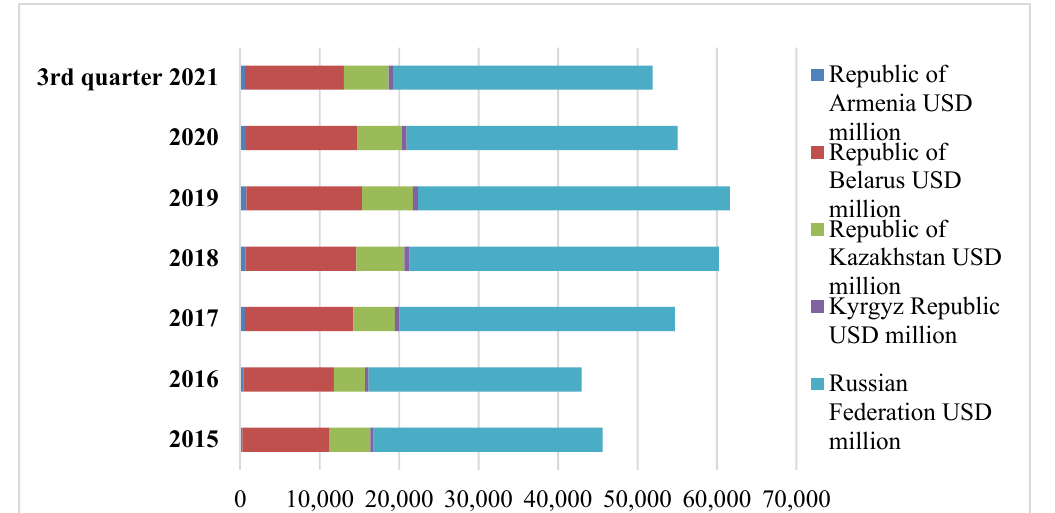
Figure 2. Dynamics of mutual trade across the EAEU countries, USD million. Source: Our own calculations based on the Eurasian Commission (2021).